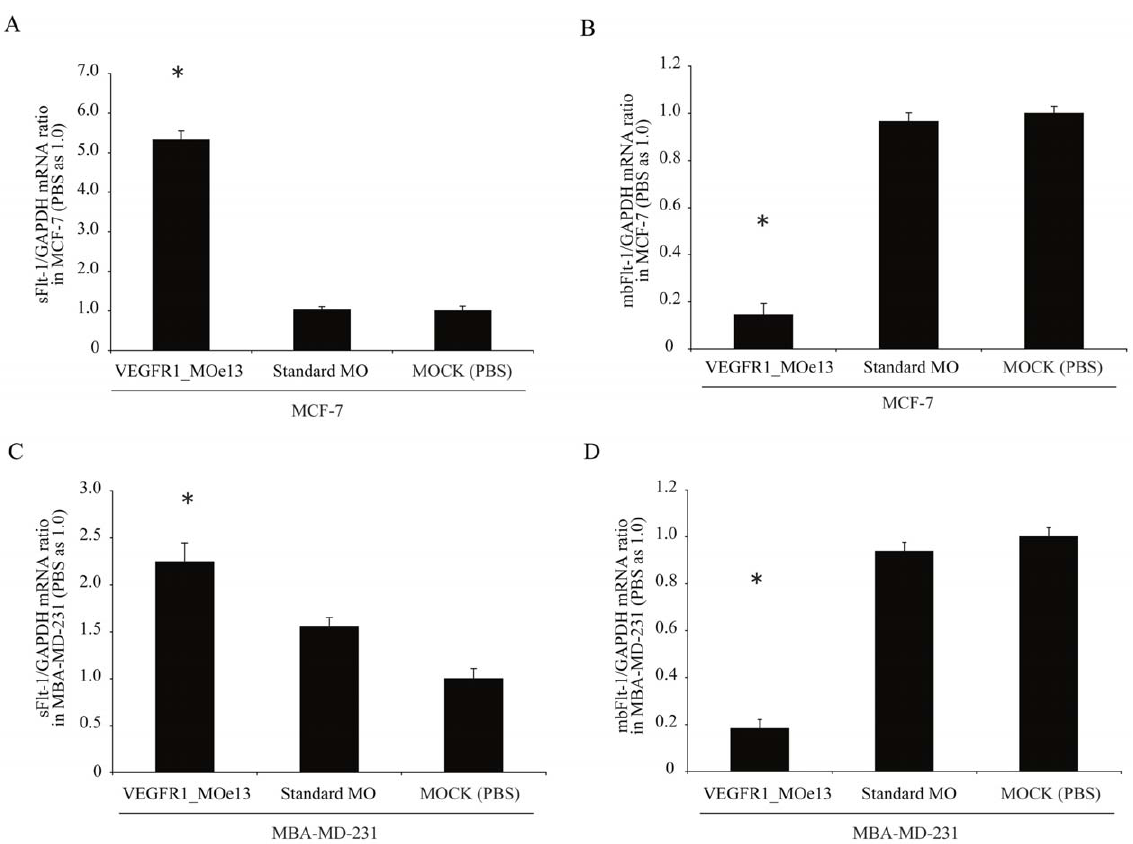
Figure 2. VEGFR1_MOe13 increases sFLT-1 and decreases mbFLT-1 mRNA in MCF-7 and MBA-MD-231 breast adenocarcinoma cell lines. MCF7 or MBA-MD-231 human breast adenocarcinoma cells were electroporated with VEGFR1_MOe13 and (a; c) sFLT-1 and (b; d) mbFLT-1 mRNA levels assessed at 72 hours using real time PCR (n=3). Data were normalized to GAPDH mRNA levels and normal MCF7 or MBA-MD-231 cells were used a 1.0. *p , 0.01.